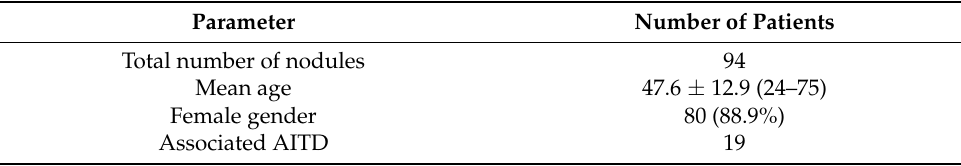
Table 1. Main characteristics of the study